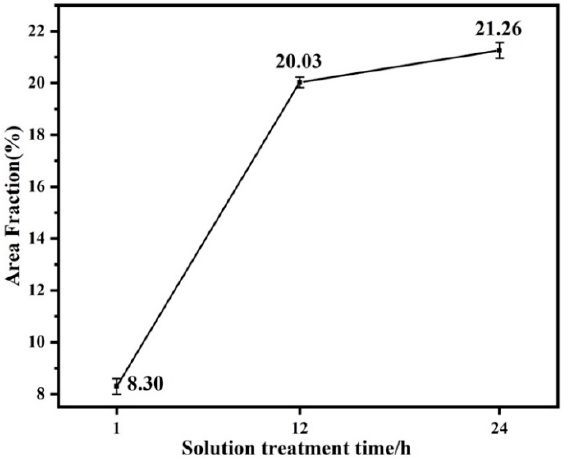
Figure 5. Area fraction line graph of LPSO Phase in Solid Solution Alloys.